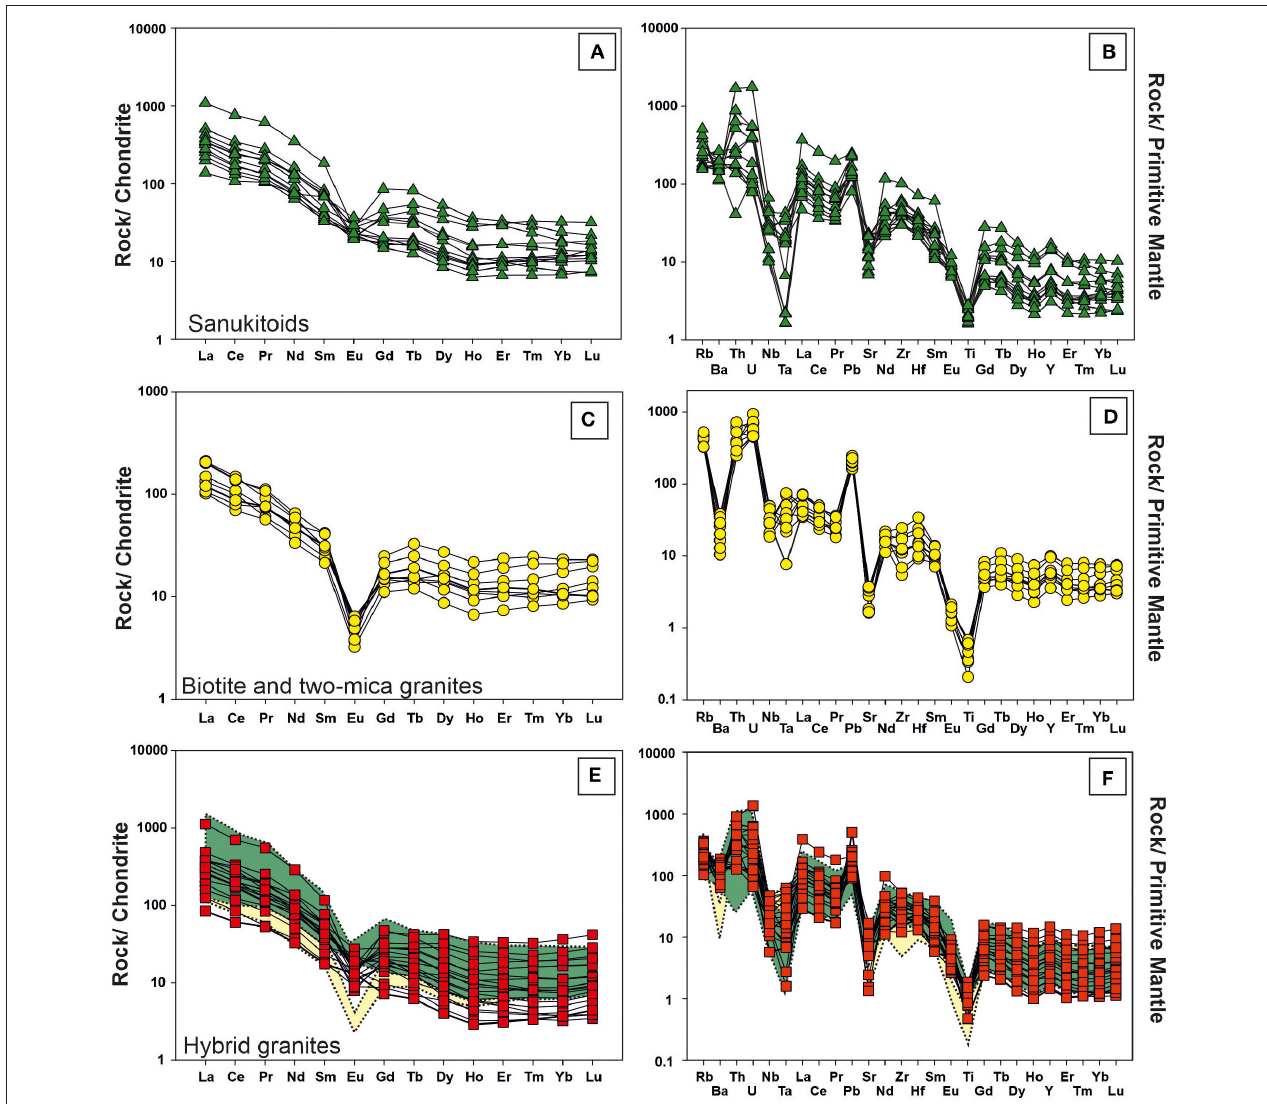
FIGURE 6 | Chondrite-normalized Rare earth element (REE) and primitive mantle-normalized multi-elemental variation diagram for the sanukitoids (A,B) , biotite and two-mica granites (C,D) and hybrid granites (E,F) . The compositional range of sanukitoids (green area) and biotite and two-mica granites (yellow area) are highlighted in the background (E,F) to show that hybrid granites are the mixtures of two primary granite types. Normalized values are from Sun and McDonough